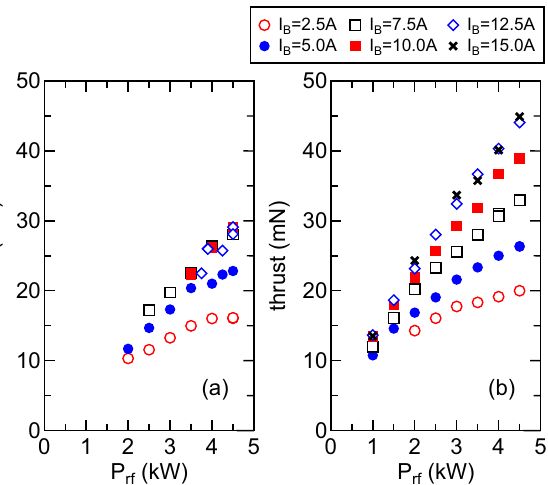
0 mode antennas, 1 and ( b ) m = = + 1 mode case. Therefore, only the thrust with the high-power transfer = + 1 mode case. Typical error bar estimated from several shot is about = +